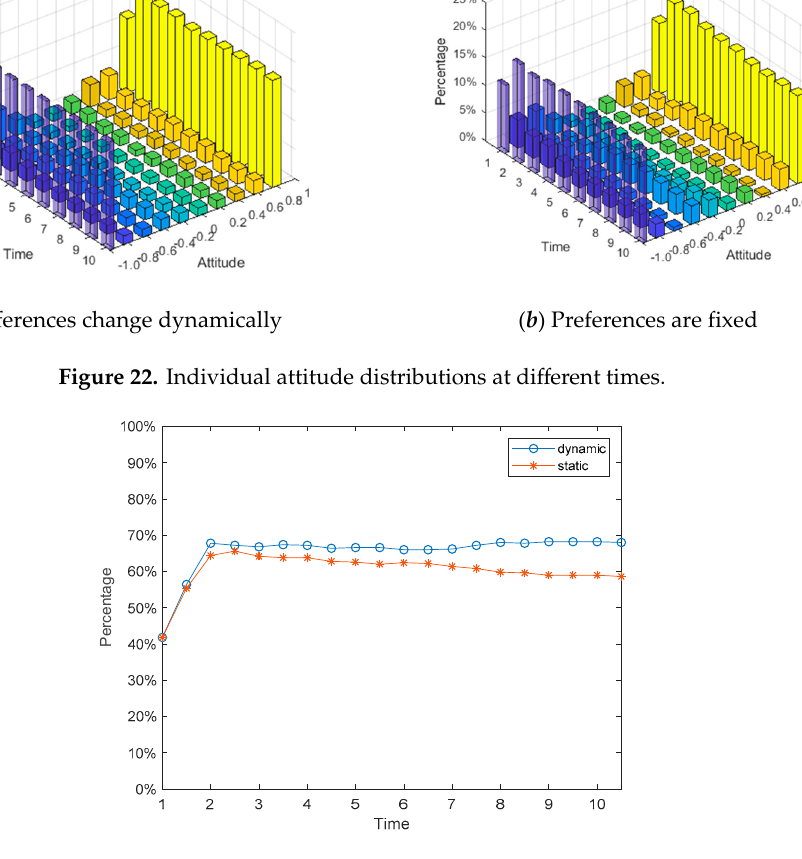
Figure 23. Polarization proportion with changes over time.